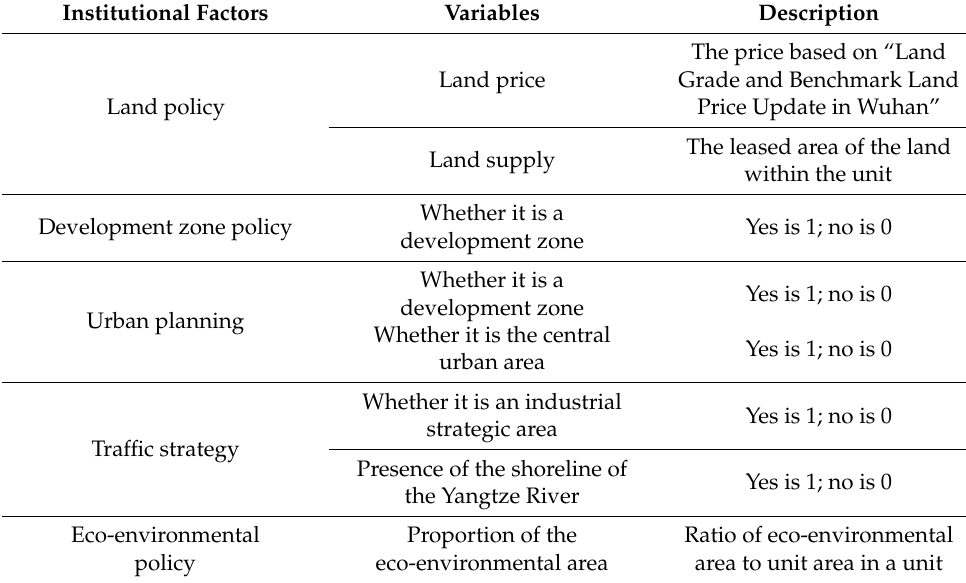
Table 1. List of explanatory